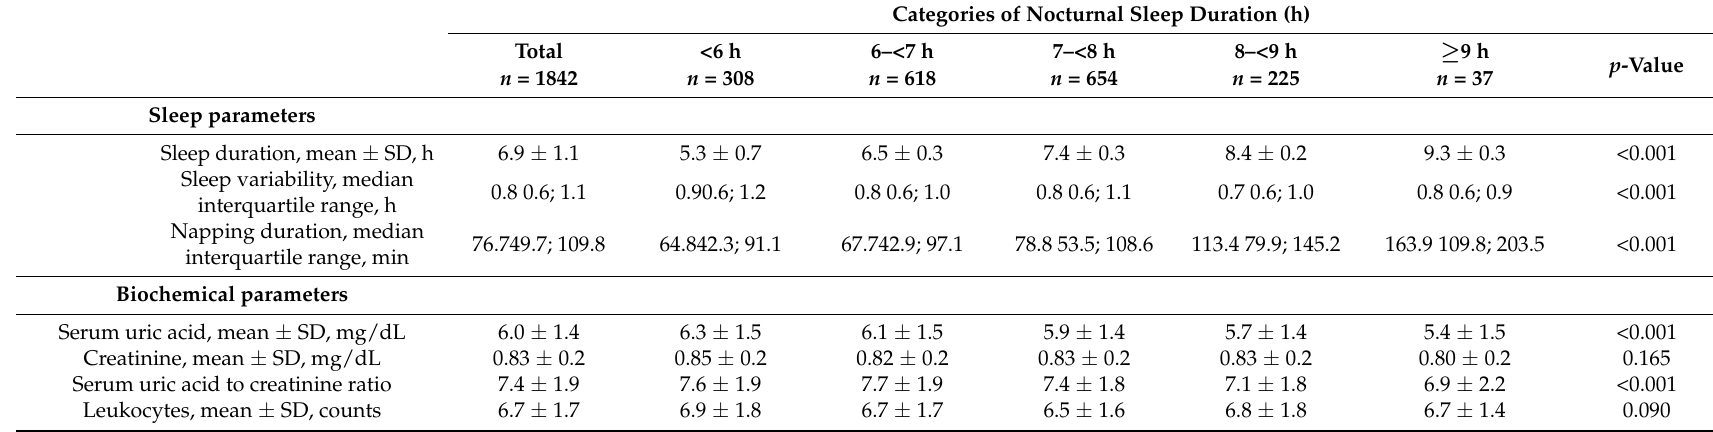
Table 2. Sleep and biochemical parameters of the study population from Prevenci ó n con Dieta Mediterr á nea-Plus trial across categories of nocturnal sleep duration.